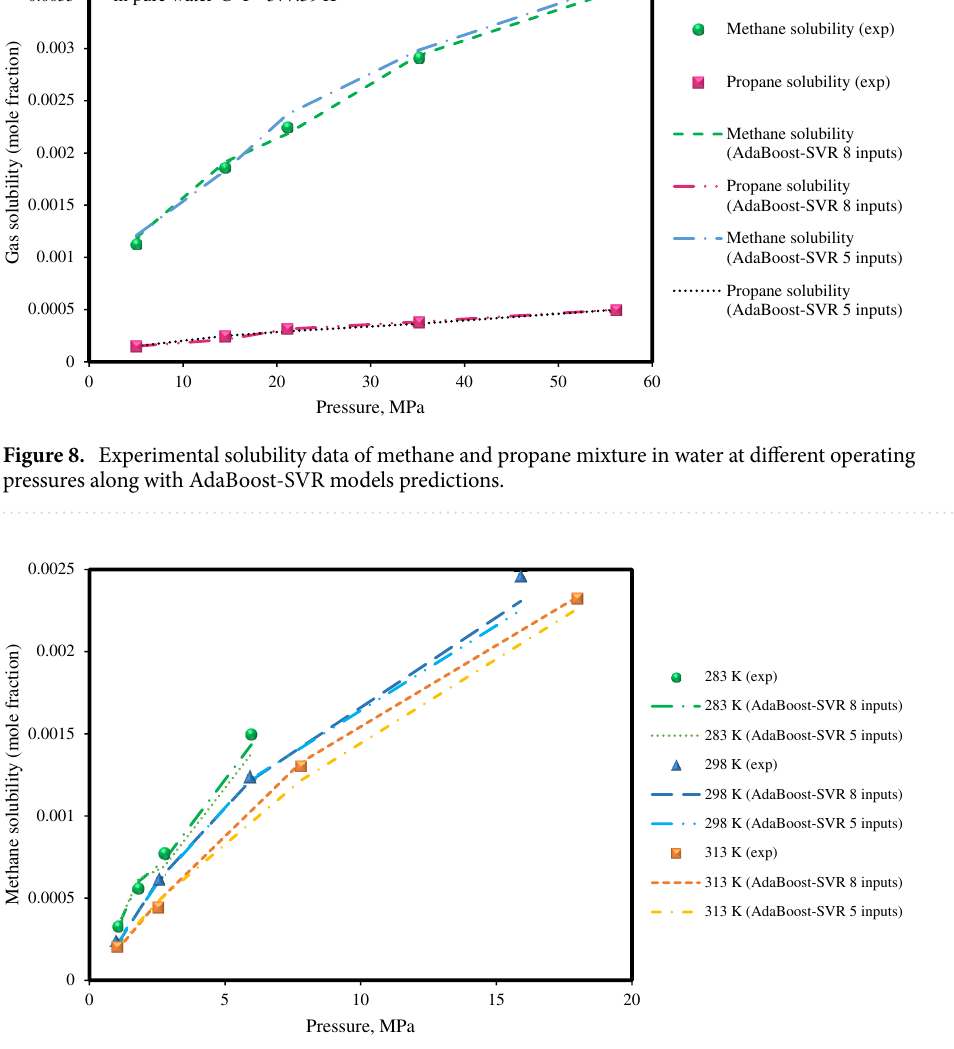
Figure 9. Experimental methane solubility data and AdaBoost-SVR models predictions for the methane + pure water system at different